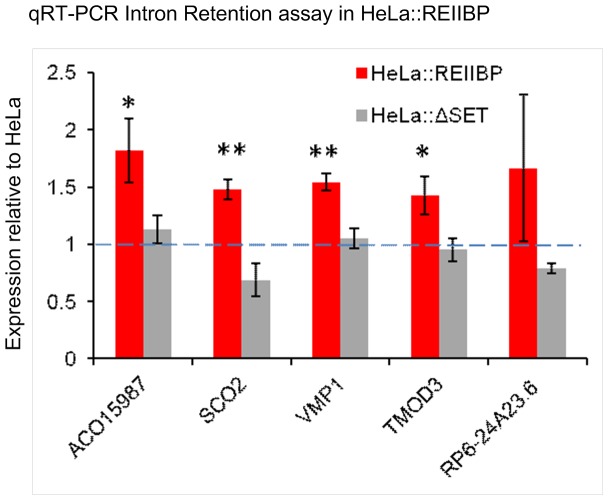
Intron retention assay.Intron retention qRT-PCR results for a subset of genes present in Table 2. Intron values for the indicated genes are normalized against the nearest exons and the βactin mRNA values. Data are shown as relative to HeLa values (blue dotted line). Each analysis is an average of at least three independent experiments. The error bars shown are the SEM, ** p value <0.005, * p value <0.05.